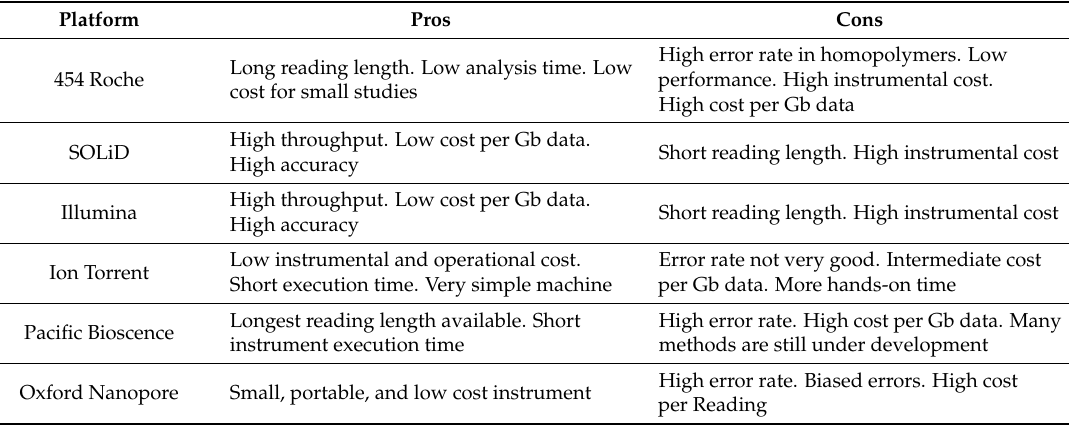
Table 3. Pros and cons of each